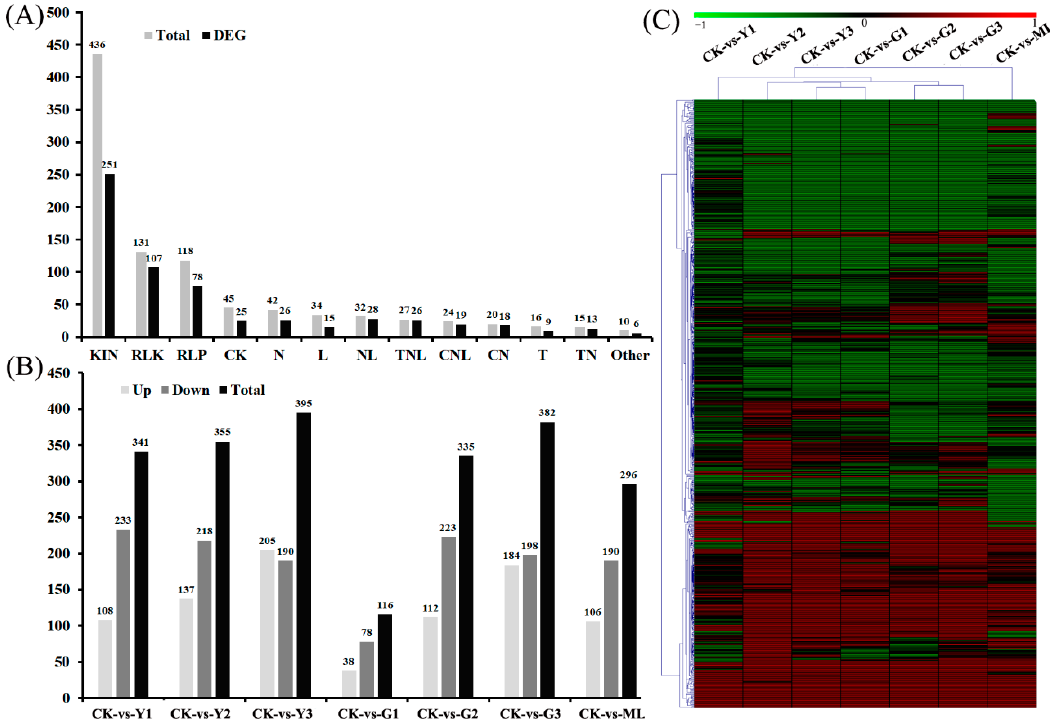
Figure 6. Differentially expression of R genes in pecan response to PMV. ( A ) Classification and quantity of predicted pecan R proteins. ( B ) Differentially expressed R genes in different infection leaves compared to CK. ( C ) Heatmap of differential expression of R genes. Responsive progression of gene expression under different samples infection PMV compared to CK. Heat maps were drawn using the Log2 ratio (transformed FPKM value of PMV infection/those of CK). Detailed gene and expression data are provided in Table S13, available as Supplementary Data online.